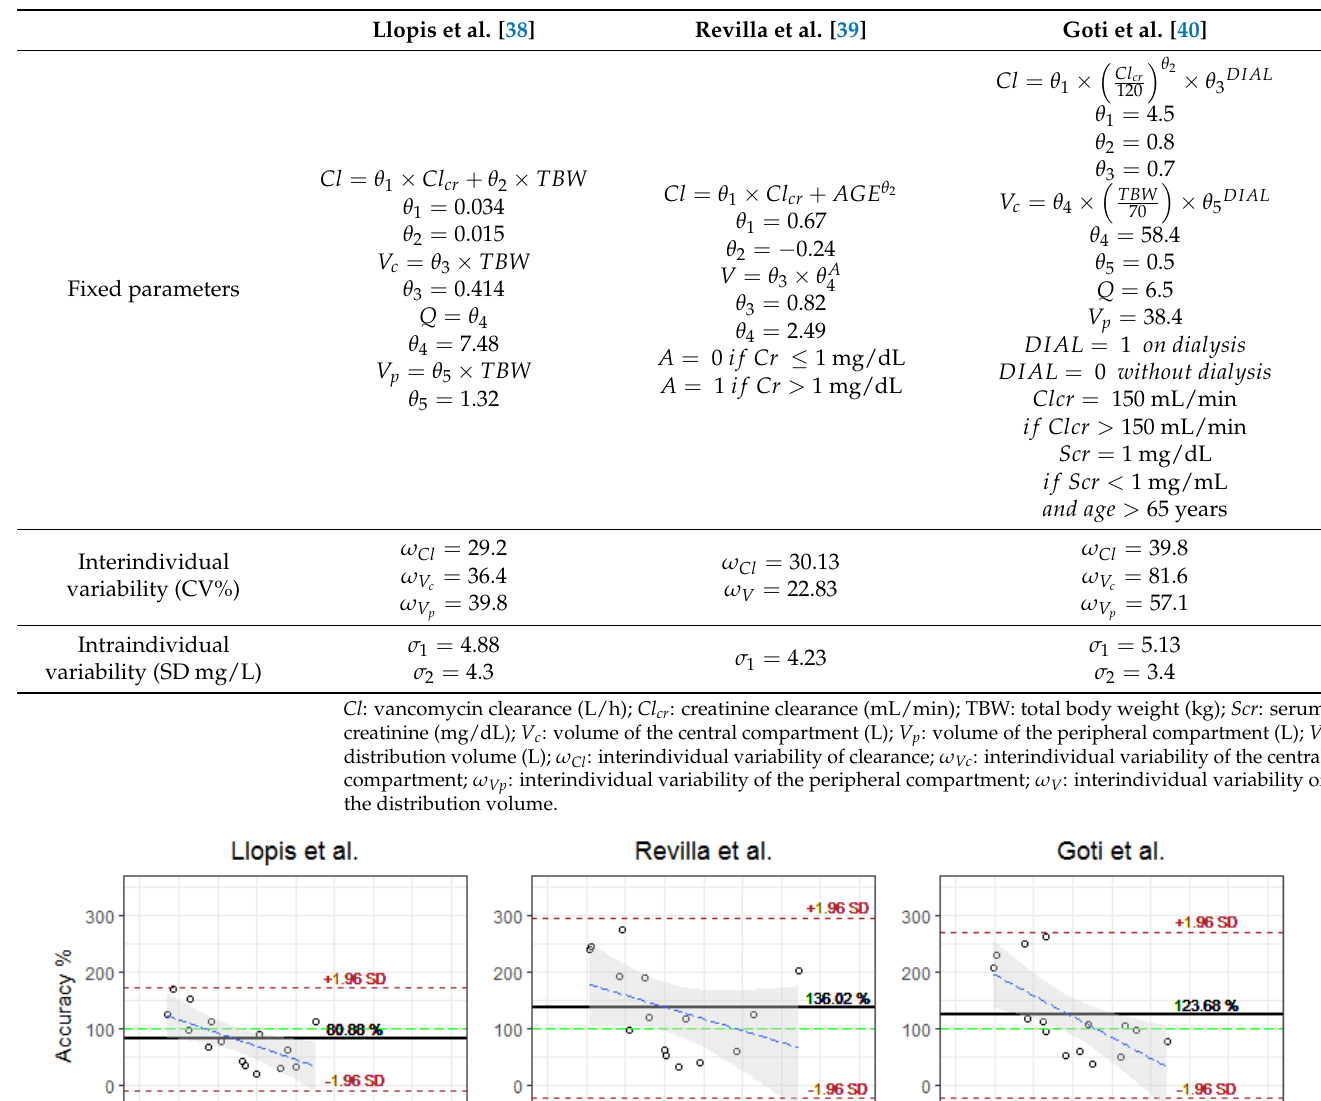
Table 2. Model of population pharmacokinetic parameters of vancomycin chosen for our study.